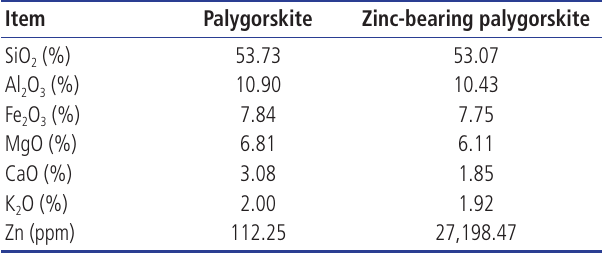
Table 1. The chemical composition of the palygorskites